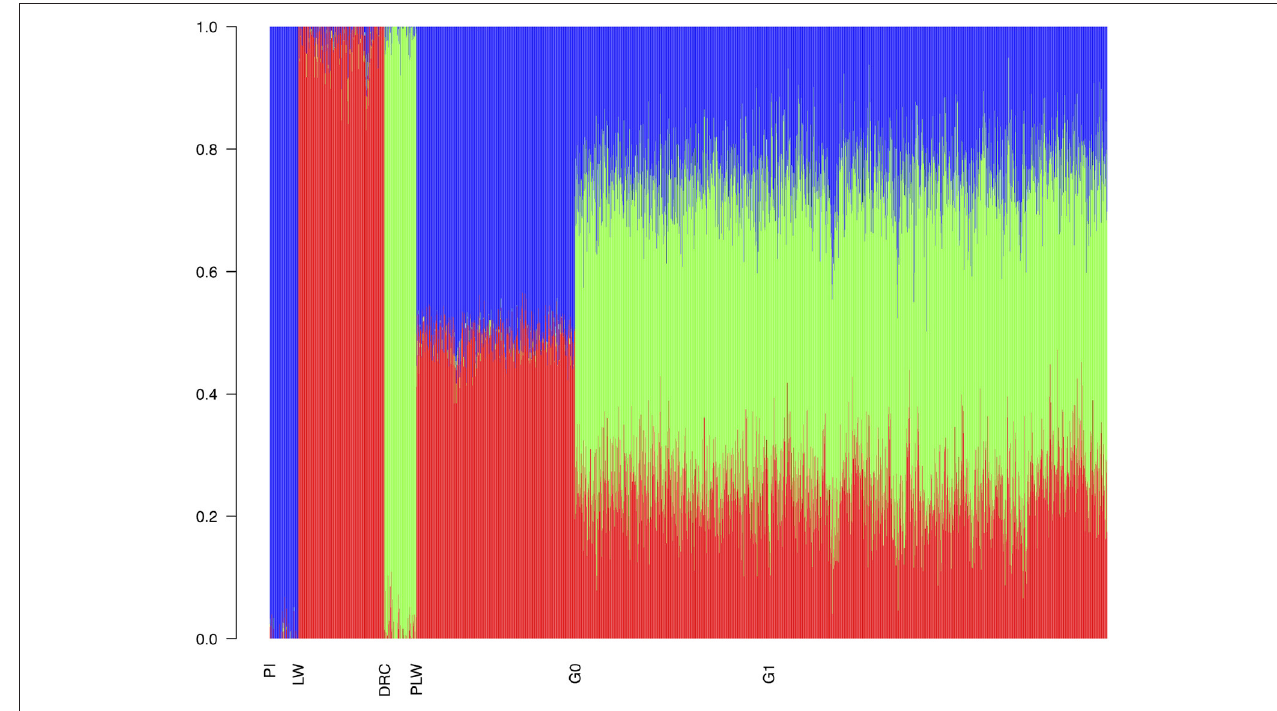
FIGURE 4 | Admixture analysis of each population from the three-way crossbreeding. The number of clusters was set to K = 3. DRC, Duroc; G0, (Pietrain × Large White) × Duroc offspring; G1, G0 × G0 offspring; LW, Large White; PI, Pietrain; PLW, Pietrain × Large White.